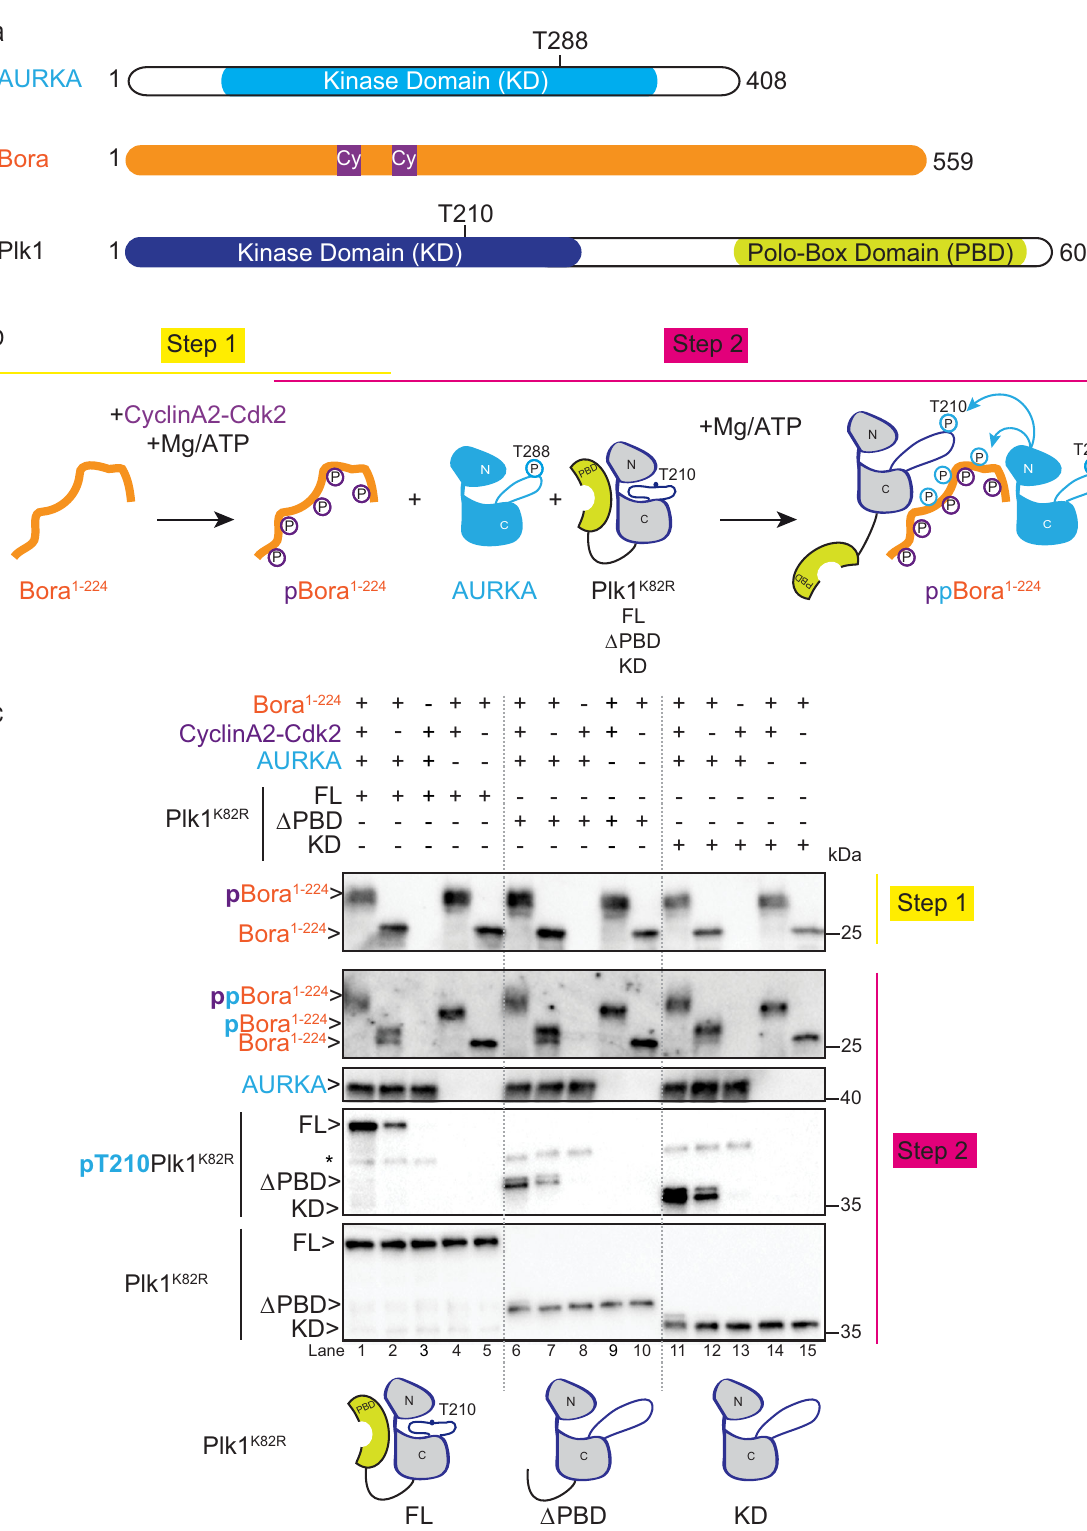
resonance peaks remained clustered between 8.5 and 7.5 ppm on the 1 H axis suggesting that phosphorylation of Bora did not induce a transition to an ordered tertiary structure. Addition of unlabeled Plk1 KD to non-phosphorylated Bora 1 – 224 or to Cyclin-Cdk-phosphorylated Bora 1 – 224 revealed little peak shifting or line broadening (Fig. 2a, b, left panels respectively). In